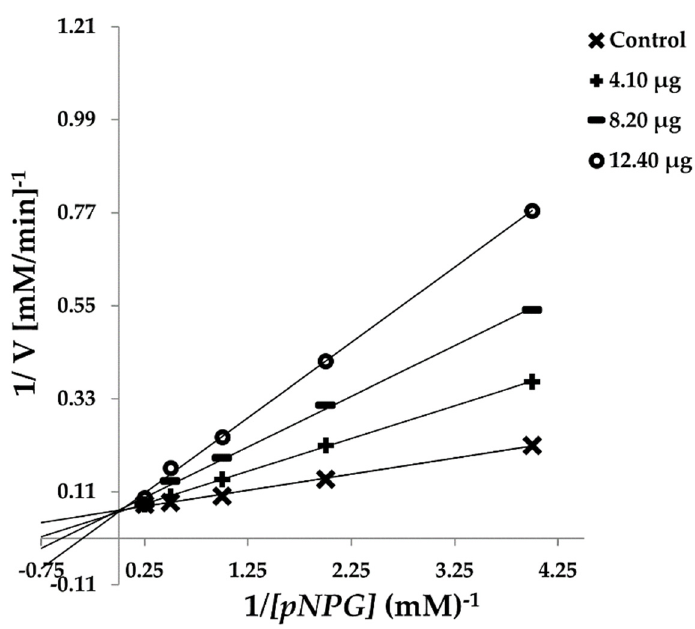
Figure 4. Lineweaver–Burk plot showing substrate-dependent enzyme kinetics when the crystal α -glucosidase compound inhibits α -glucosidase enzyme. compound inhibits